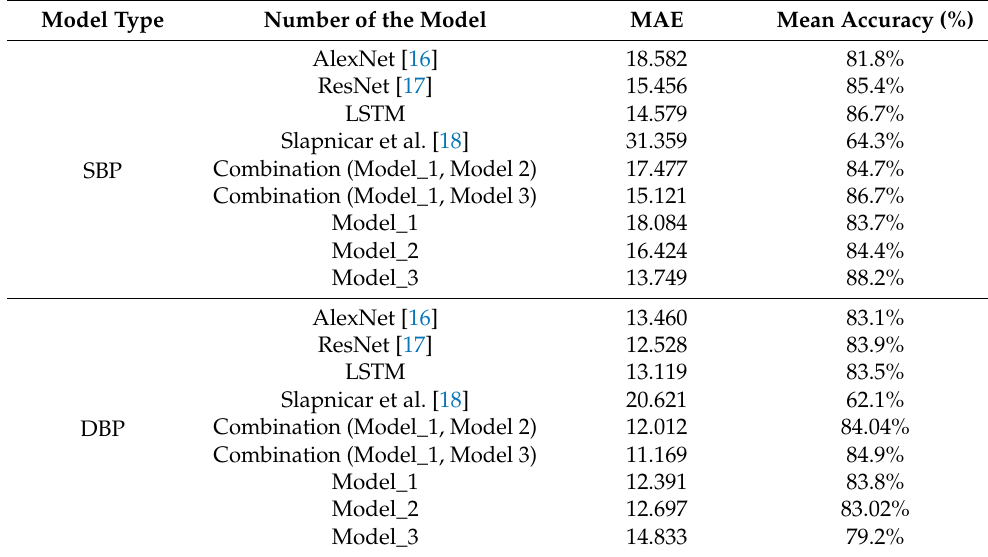
Table 5. Comparison between our models and available pretrained models using “V4V test set